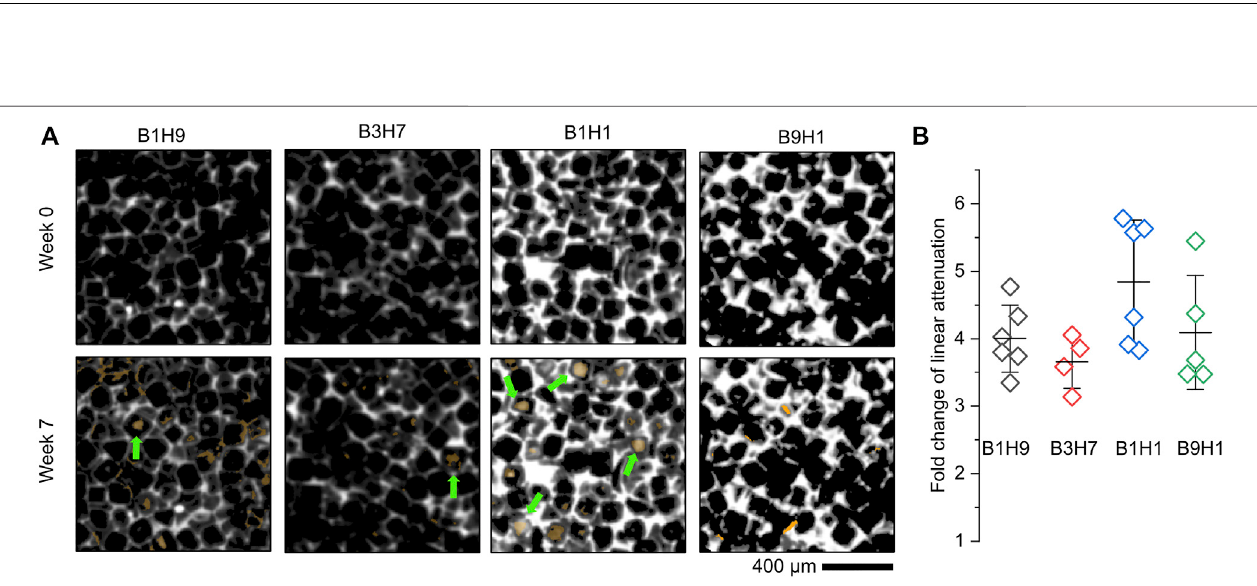
FIGURE 5 | High-resolution micro-CT analysis after 7 weeks of static culture. (A) Grayscale micro-CT images of B1H9, B3H7, B1H1, and B9H1 nanocomposite scaffolds before and after the cell culture. The formed mineral is highlighted in orange. The yellow arrows point to mineral clusters in the pores. The scaffolds appear brighter with an increase in barium titanate content within the composition. (B) Fold change of the linear attenuation within the pores of these scaffolds before and after culture; B1H9 (n = 6), B3H7 (n = 4), B1H1 (n = 6), and B9H1 (n = 5) samples. The data are shown as mean ± s.d. A statistically signi fi cant difference was tested by one-way ANOVA with Holm-Bonferroni post-hoc correction. No signi fi cant difference was found.